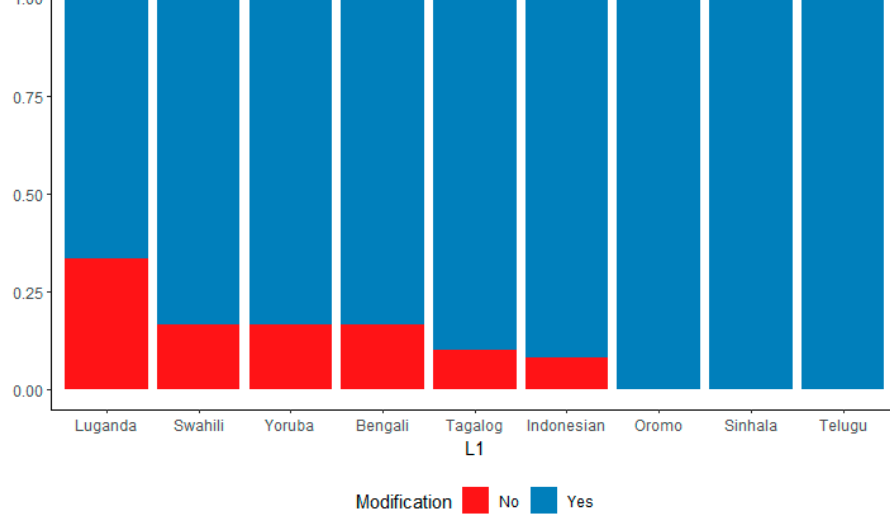
Figure 6. Production accuracy of onset CCs as a function of the L1 of the FDH participants.